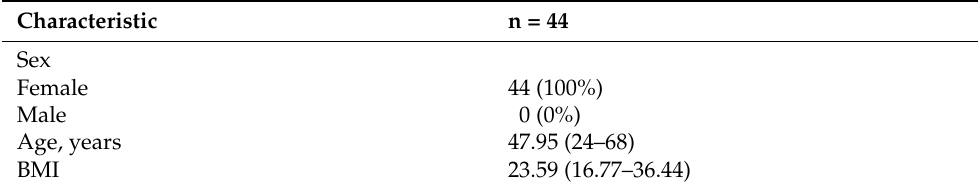
Table 1. Baseline characteristics of the patients. BMI Body Mass Index, ECOG the Eastern Cooperative Oncology Group, ER estrogen receptor, PR progesterone receptor, HER2 human epidermal growth factor receptor 2, FISH fluorescence in situ hybridization, AR androgen receptor, pCR pathological complete response, TCHP taxanes, carboplatin, trastuzumab and pertuzumab, NPHP N: